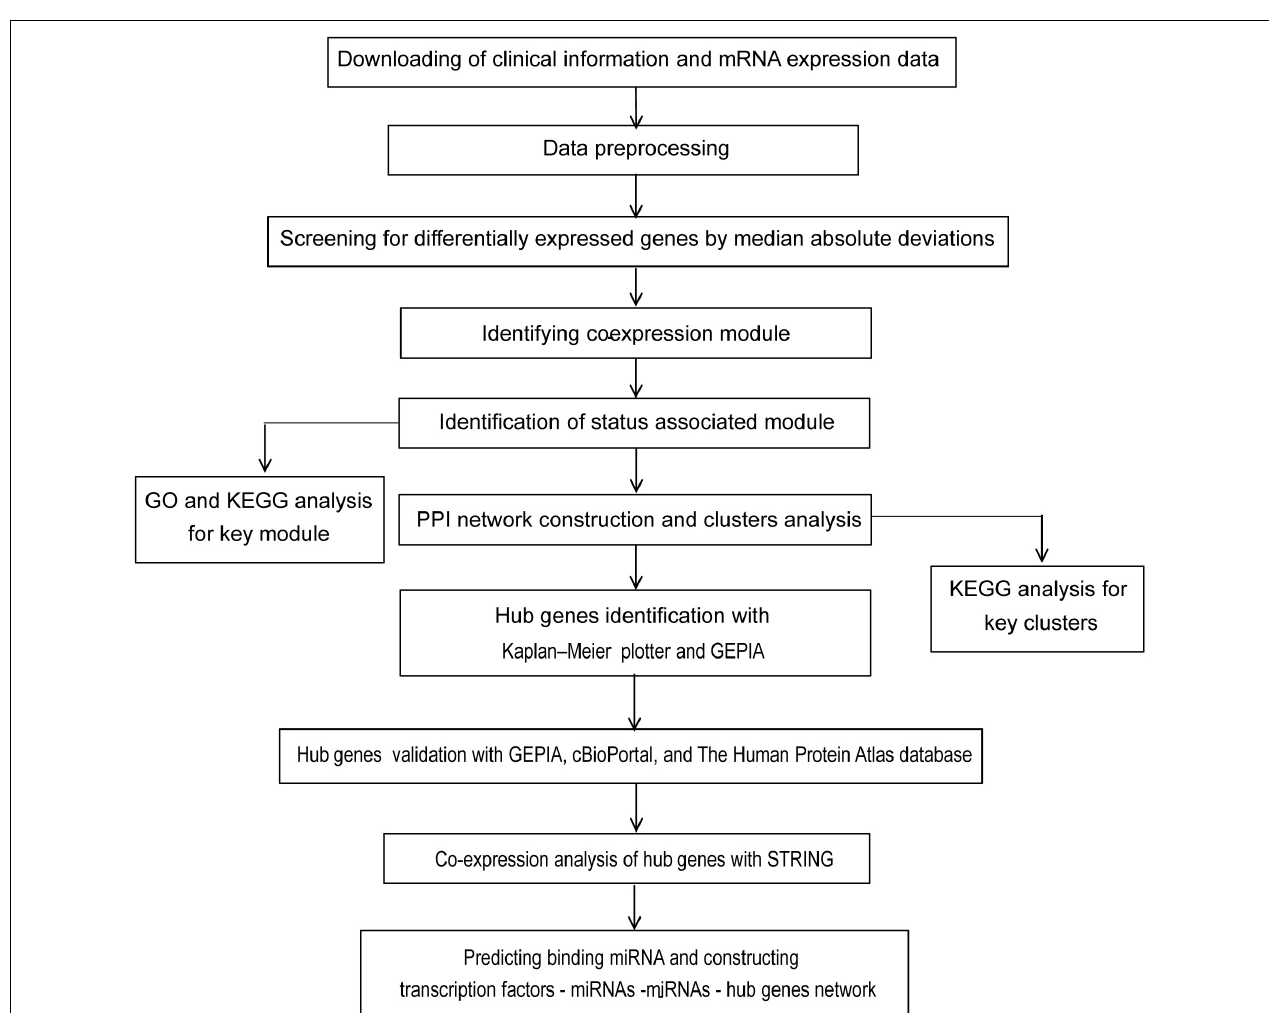
FIGURE 1 | Flow chart of strategy for data preparation, processing, analysis, and validation used in this study.